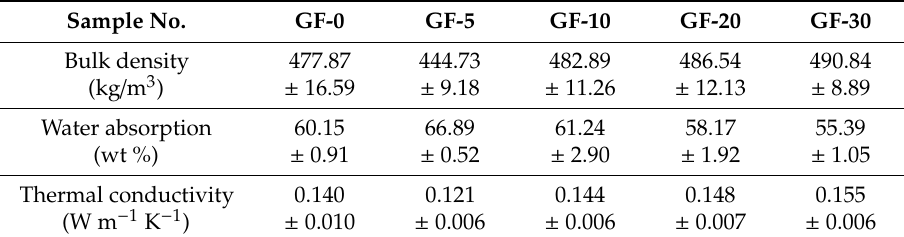
Table 3. The physical properties of the geopolymer foam